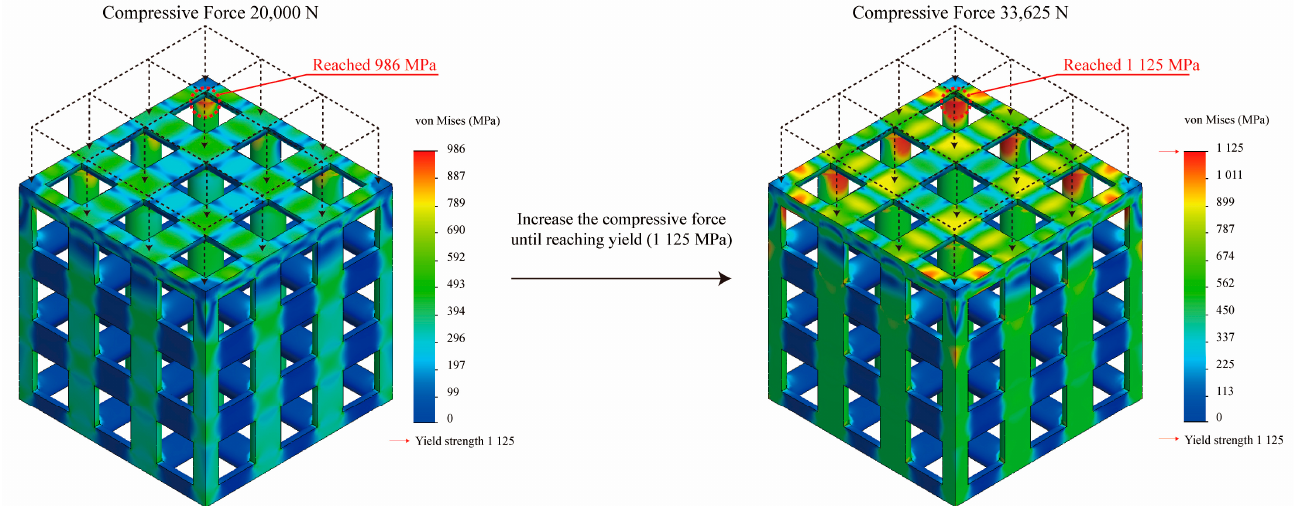
Figure 13. Yield stress derivation using fi nite element analysis.